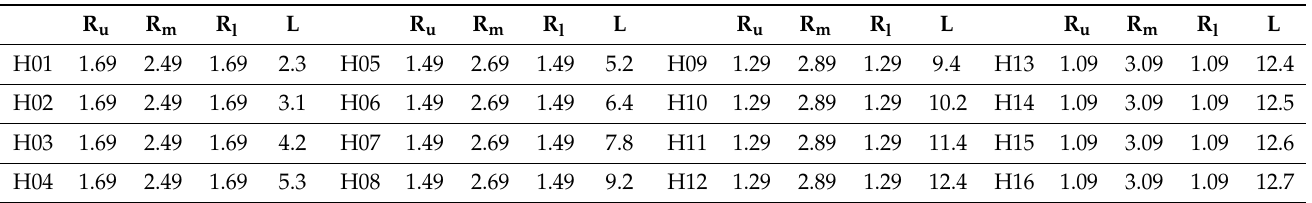
Table 2. The optimal parameters of multiple parallel connection HRs with the olive apertures (unit: mm).